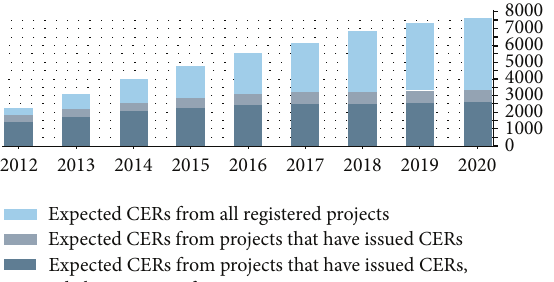
Figure 1: CER production forecast during the period 2013–2020 made by UNFCCC